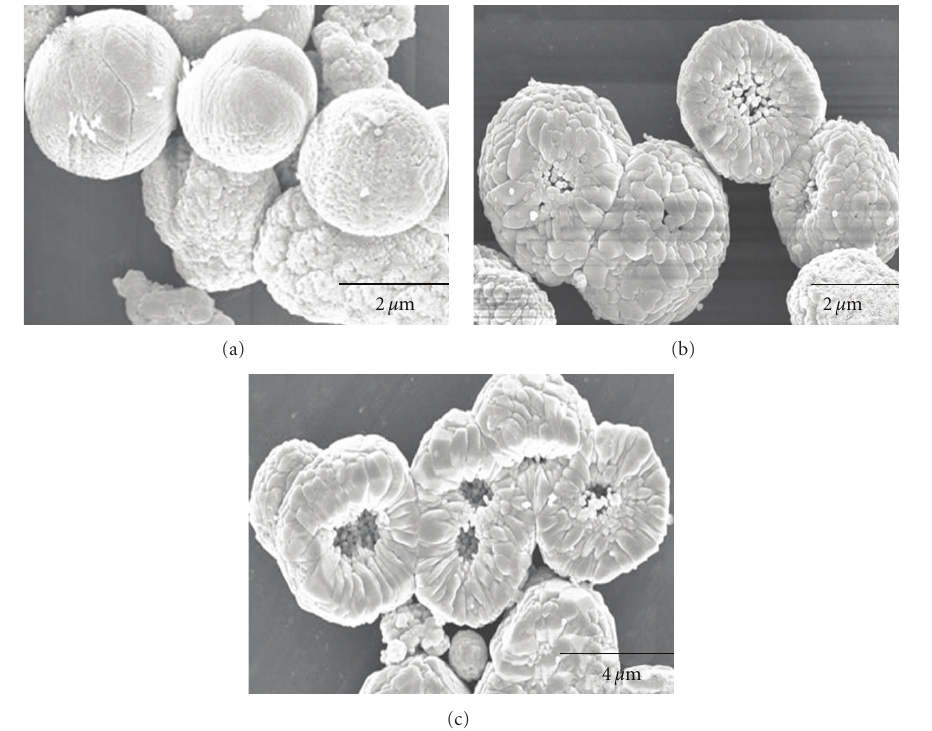
Figure 5: SEM images of BiVO 4 samples prepared with 9g urea at di ff erent reaction time from 1 (a), 6 (b), to 12 h (c).